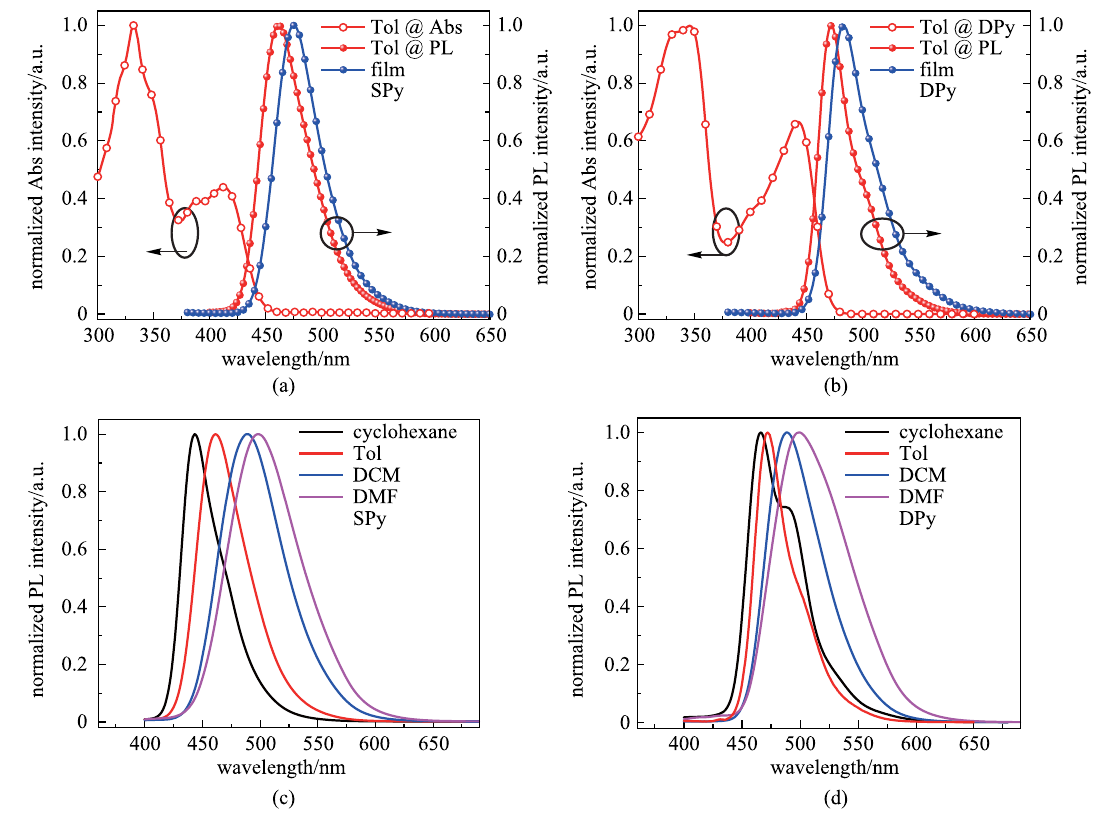
Fig. 4 UV–vis absorption and PL measurement results. a , b are UV–vis absorption (Abs, room temperature) and fluorescence (Fl, room tem- perature) in dilute toluene (Tol), as well as fluorescence (Fl, room temperature) in film. c , d are fluorescence (Fl, room temperature) spectra in different solvents (cyclohexane, Tol, dichloromethane (DCM), and N , N -dimethylformamide (DMF)). a , c are for SPy , b , d are for